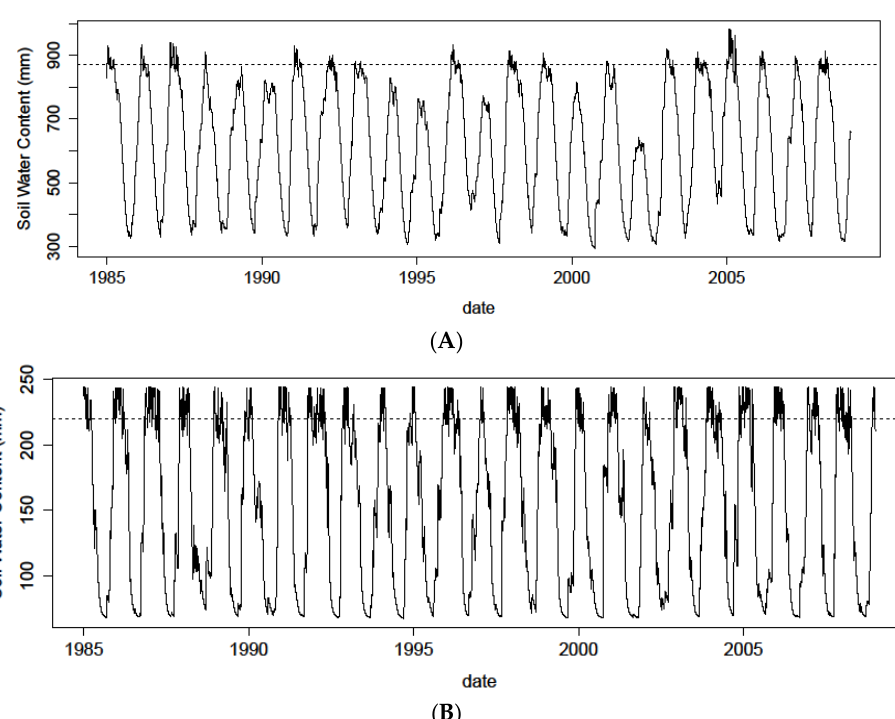
Figure 6. Daily predawn leaf water potentials for Quercus suber measured (black dots, mean and standard deviation) during the year 2008, and simulated (black line). The horizontal dotted line illustrates the − 1 MPa threshold, from day of the year which drought onset t 1 and drought offset t 2 are deduced when the simulated predawn water potential reaches this threshold.